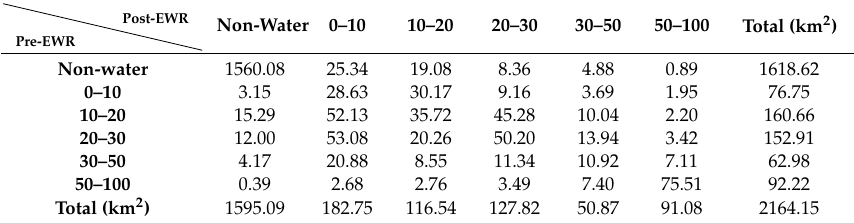
Table 2. Area transfer matrix of inundation frequency (%). Vertically, the table is a classification of inundation frequency during the pre-ecological water replenishment period; horizontally, the table shows the classification of inundation frequency during the post-ecological water replenishment period.